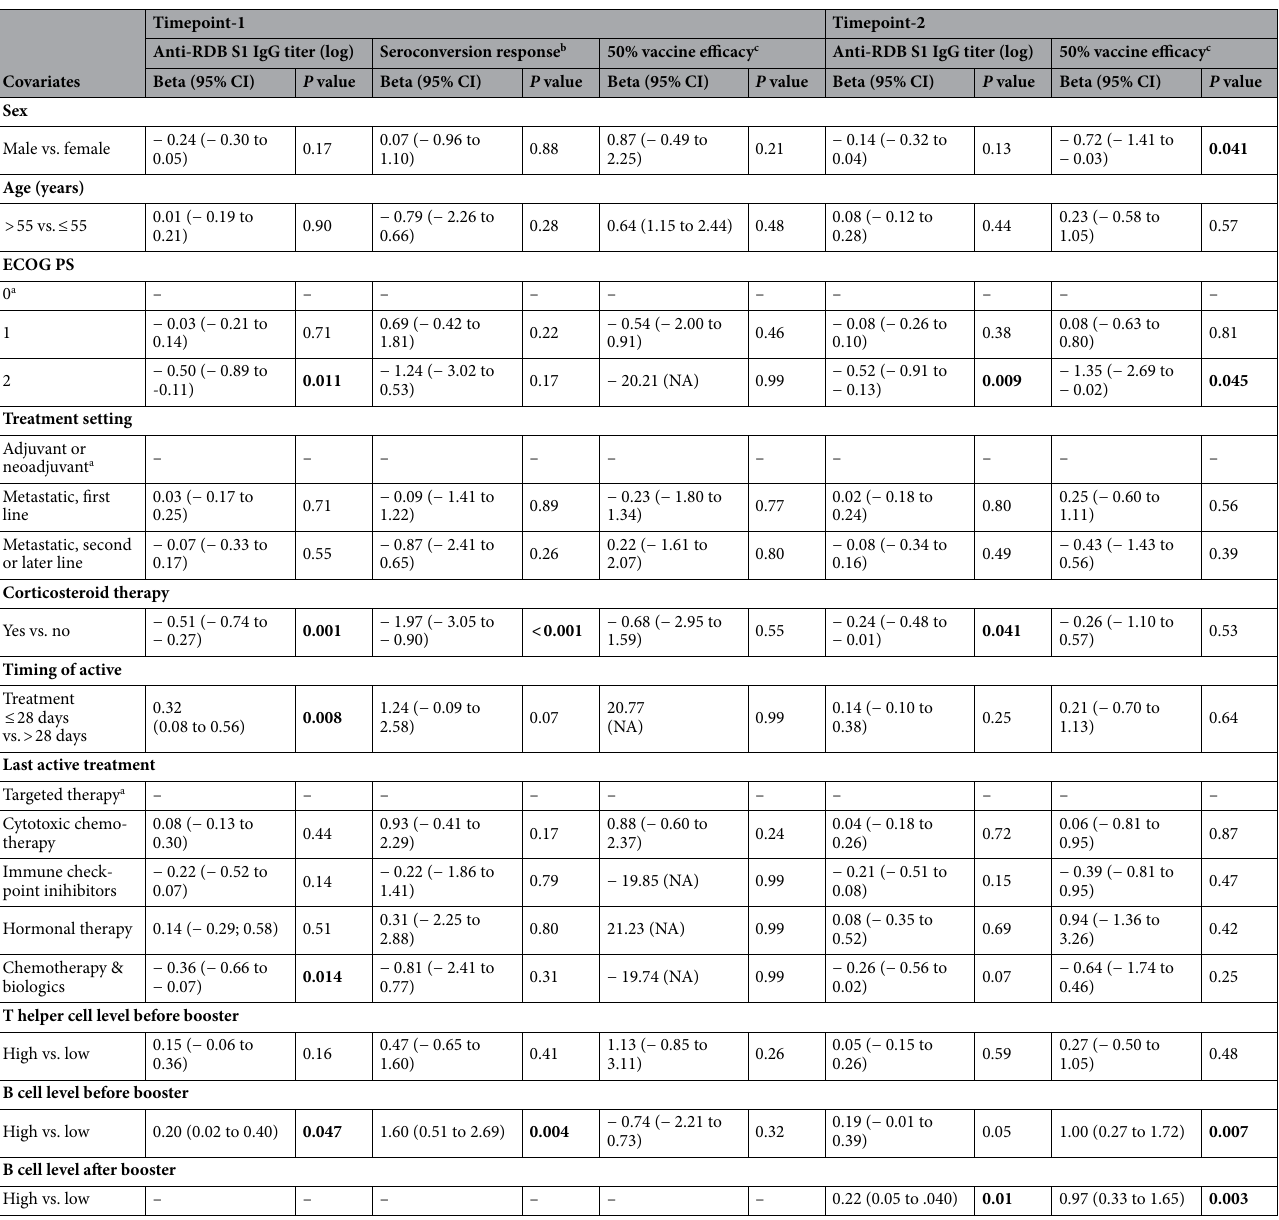
Table 3. Multivariate analysis of antibody response. Statistically significant P values are highlighted in bold. P values derived from parametric 2-sided Wald’s χ 2 test with Bonferroni (α = 0.01) correction for multiple comparisons. A two-sided P value of < 0.05 was considered statistically significant. RBD-S1, receptor binding domain of the S1 subunit of the SARS-CoV-2 spike protein; log, logarithmic values; IgG, immunoglobulin G; AU, arbitrary unit; CI, confidence intervals; ECOG PS, Eastern Cooperative Oncology Group Performance Status; NA, not applicable. a Reference category; b Seroconversion response at cut-off ≥ 50 AU/mL; c 50% vaccine efficacy response at cut-off ≥ 4446 AU/mL; Timepoint-1 denotes antibody response assessment before the third dose of tozinameran; Timepoint-2 denotes antibody response assessment four weeks after the third dose of